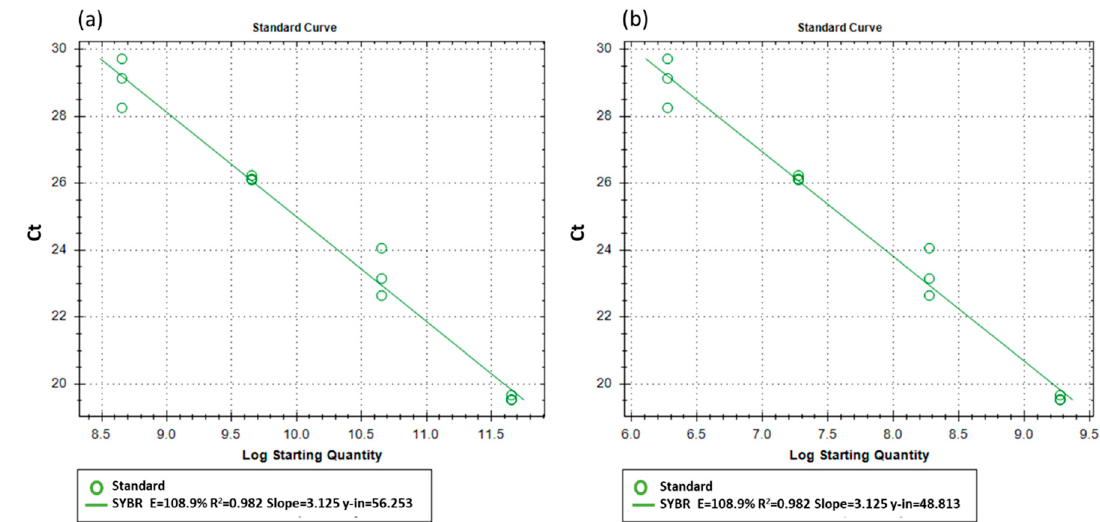
Figure 1. ( a ) The propidium monoazide (PMA)-treated standard curve for B. subtilis QST 713 of Ct to copy number generated from genomic DNA; ( b ) The PMA-treated standard curve for B. subtilis QST 713 of Ct to log 10 total number of viable populations.